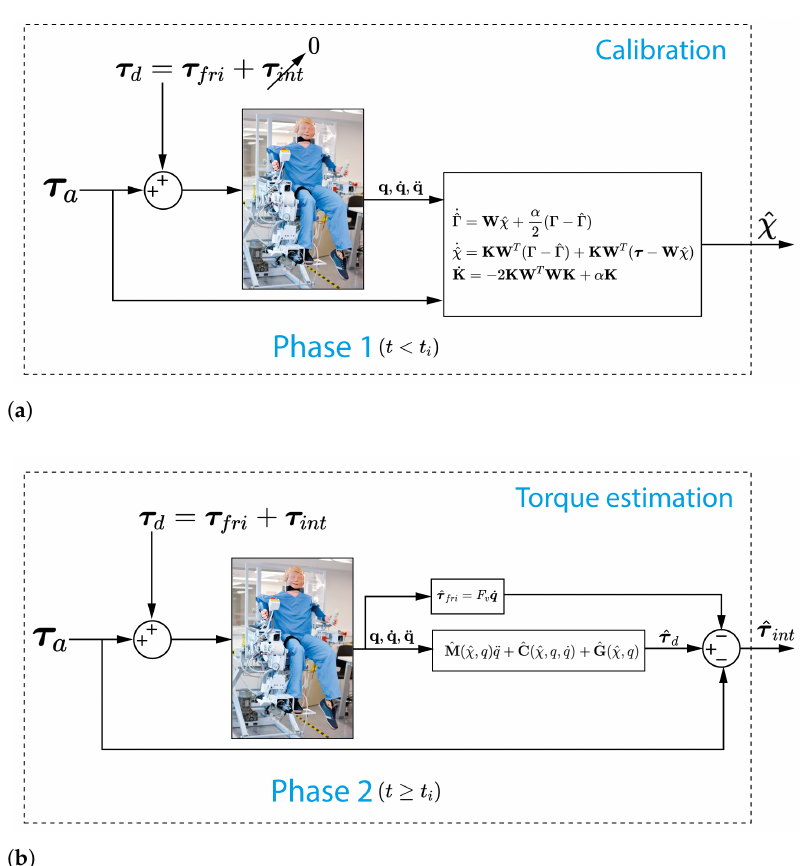
Figure 2. Block diagrams for the IID. ( a ) Calibration phase and ( b ) torque estimation